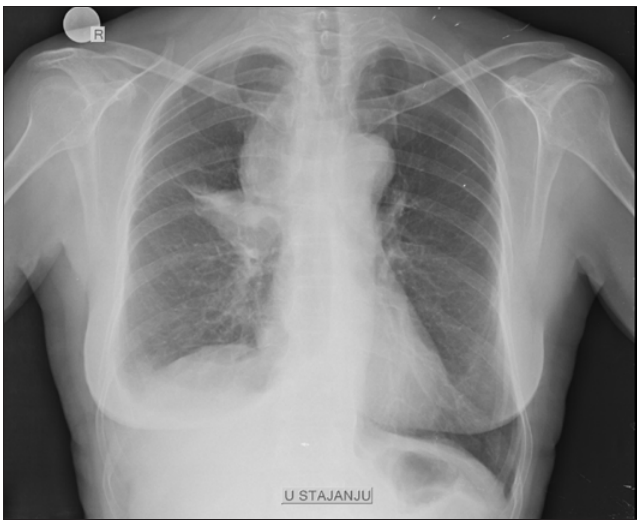
Figure 1. Increased shading in the right diaphragm and costo-diaphragmatic sinus